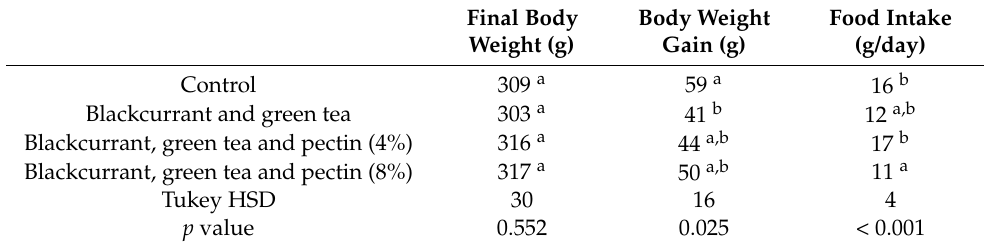
Table 2. Rat body weight and food intake.